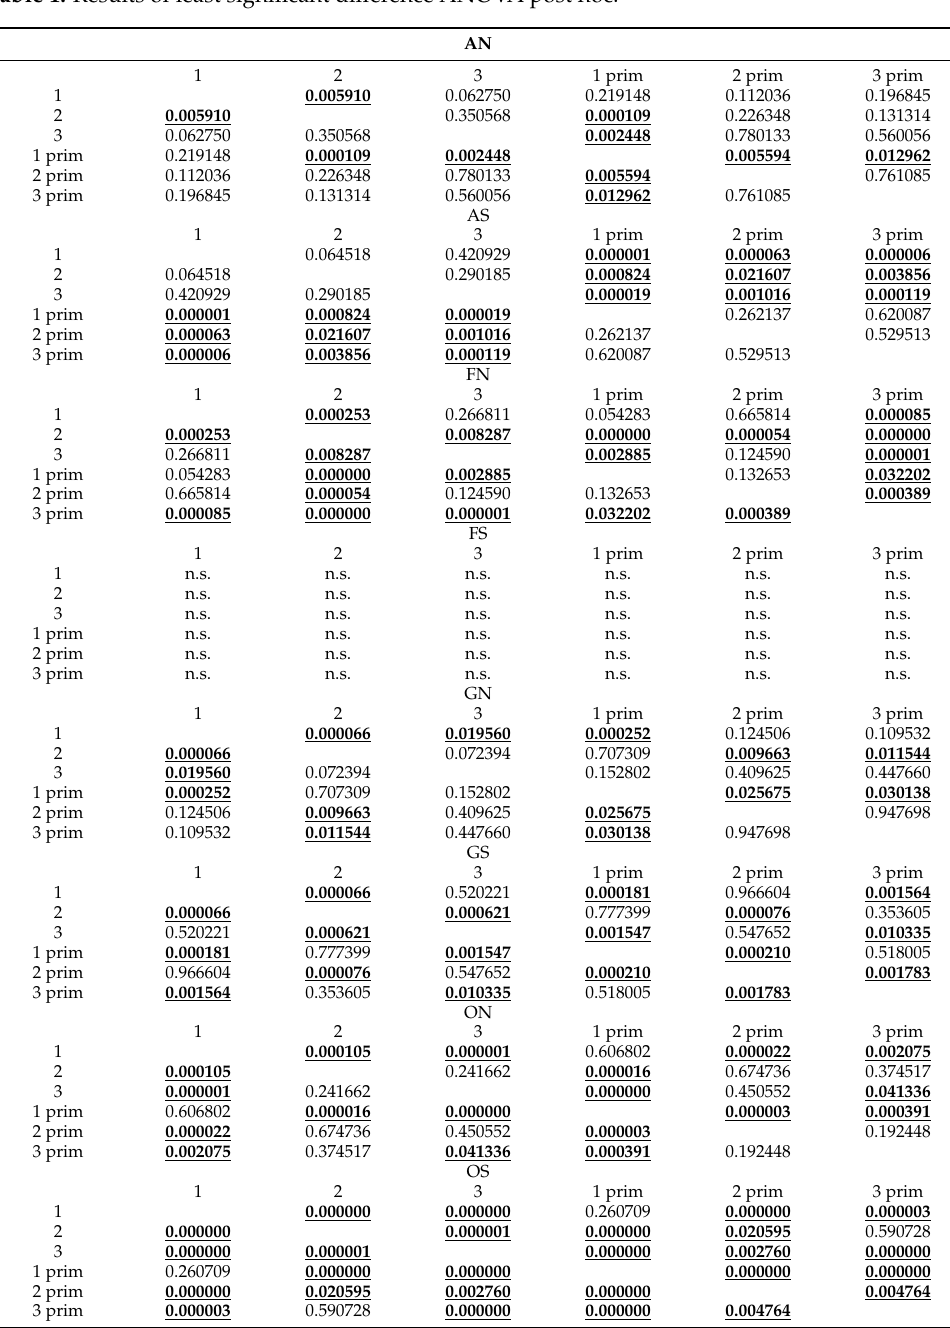
Table 1. Results of least significant difference ANOVA post